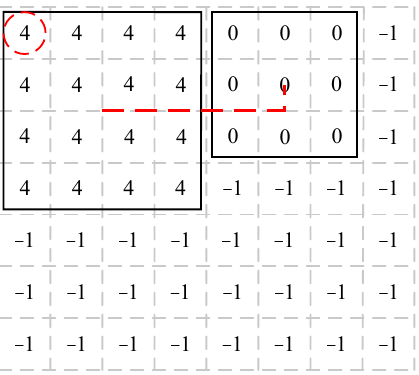
Figure 3. The representation of chiplet location and distance between chiplets. The initial layout of the system is shown in Figure 4, and the CEC was 1209.56 µ J, which was calculated by Equation (2).